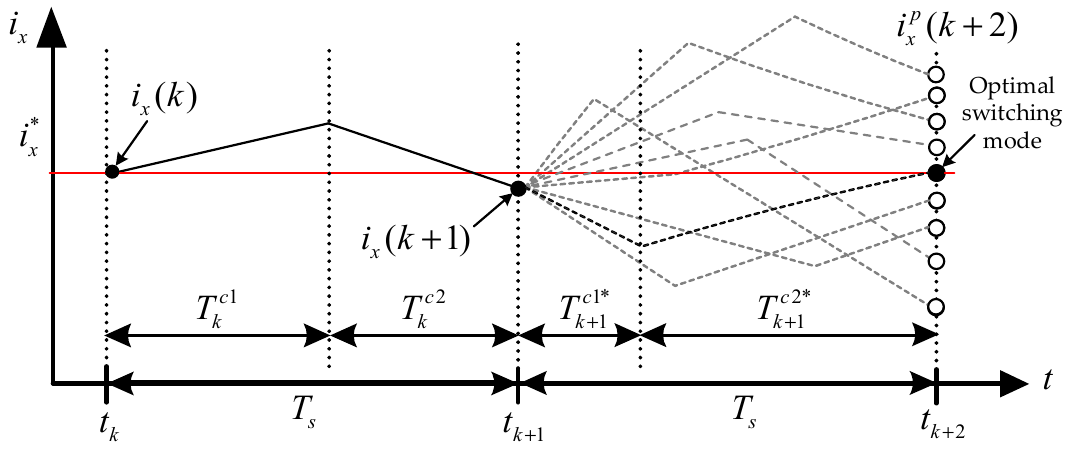
Figure 6. MMPCC schematic control diagram of stator current prediction.